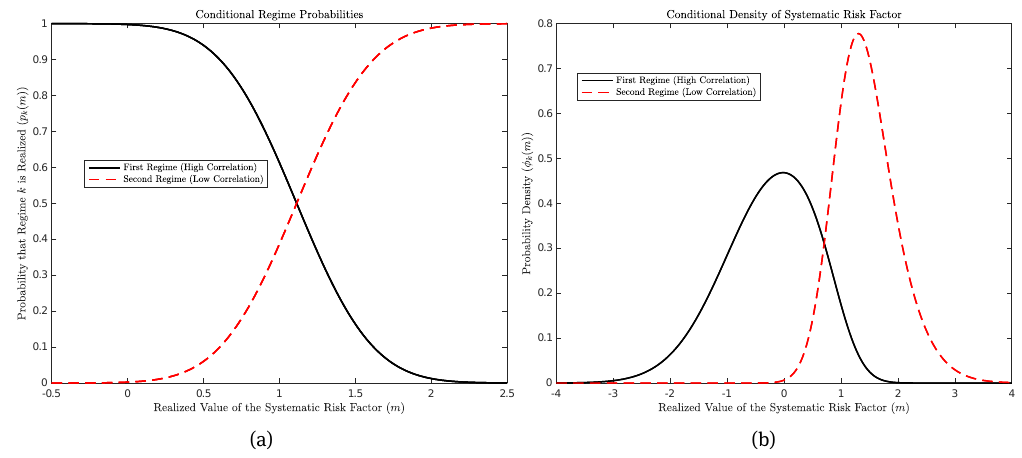
Figure 4.1: Panel (a) depicts the relationship between the economic environment and conditional regime probabilities. More precisely, it depicts the graphs of p 1 (·) (solid) and p 2 (·) (dashed) in our numerical example. The horizontal axis represents the realized value of the systematic risk factor (a value of, say, m = −1.2 corresponds to an economy that is 1.2 standard deviations below average) and the vertical axis represents the conditional probability that a particular regime prevails, given the realized value of the systematic risk factor. Panel (b) depicts the conditional density of the systematic risk factor, given the prevailing regime. More precisely, it depicts the graphs of ϕ 1 (·) (solid) and ϕ 2 (·) (dashed) in our numerical